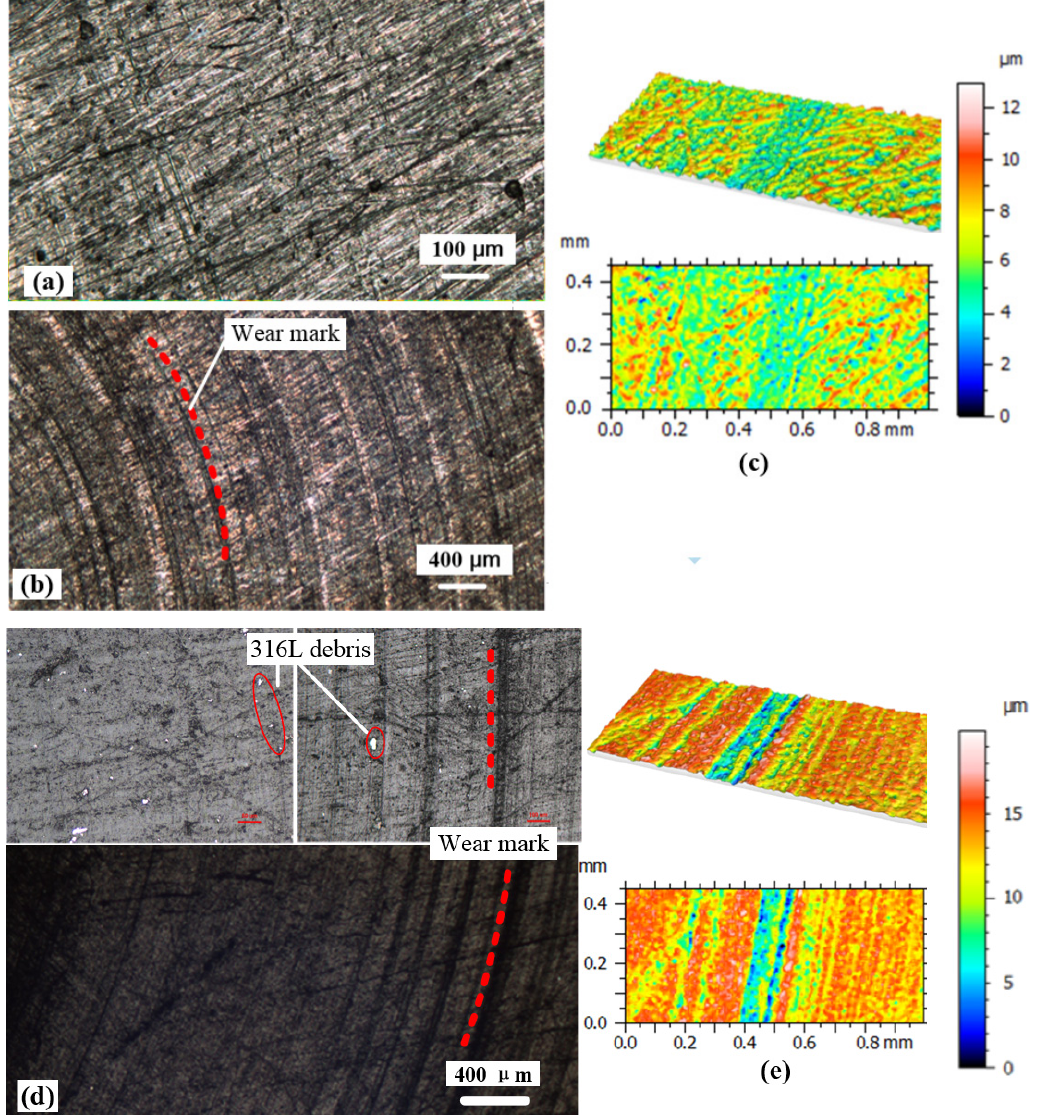
Figure 11. ( a ) The original morphology of the 316L sample polished by 120# abrasive paper; ( b , c ) the OM images and 3D morphology of 316L sample after friction experiment; ( d , e ) the OM images and 3D morphology of the PTFE sample after friction experiment.